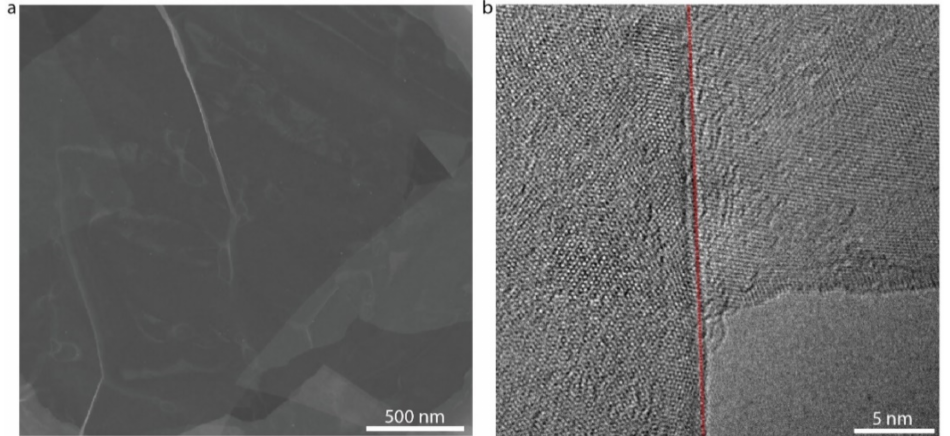
Figure 5. TEM image of LbL-assembled In 2 Se 3 thin films. ( a ) Low-resolution TEM image of the LbL-assembled In 2 Se 3 thin films. ( b ) High-resolution TEM image of the contact region between lateral nanosheets (The red dotted line is the edge of a nanosheet. The right shows the lattice of a single nanosheet, and the left shows the lattice of stacked